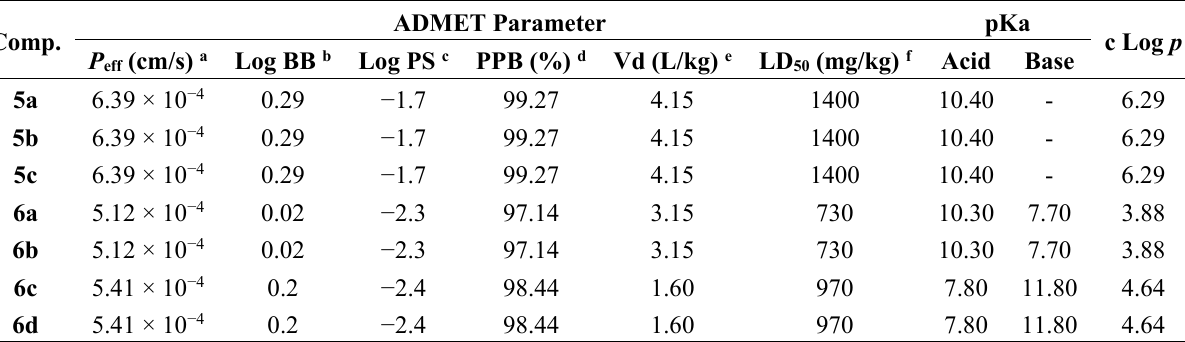
Table 4. Prediction ADMET properties for examined pleuromutilin derivatives.